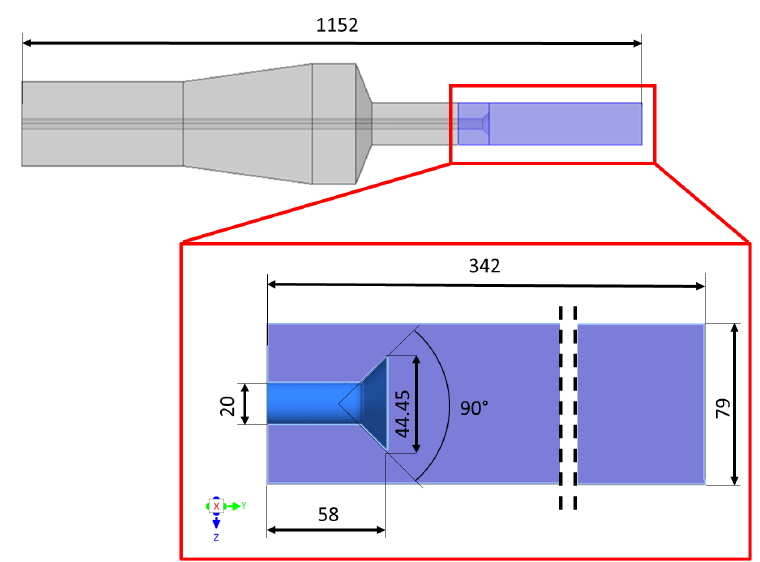
Figure 1. Representation of the numerical domain of the Vanderbilt University lab-scale burner. Dimensions are expressed in